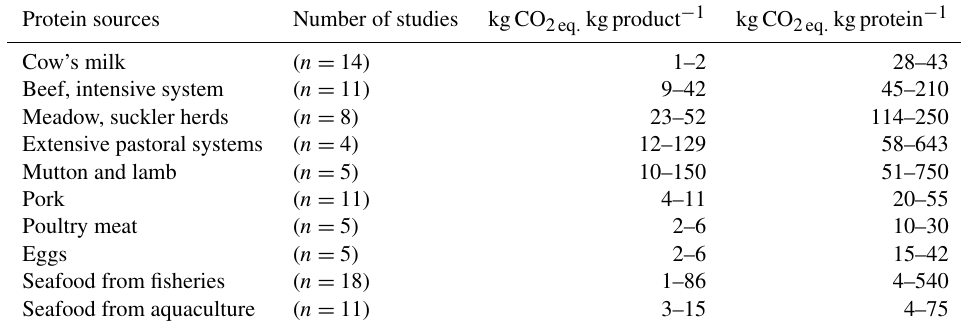
Table 16. Carbon footprints of protein of food of animal origin according to several life cycle assessment studies summarized by Nijdam et al.